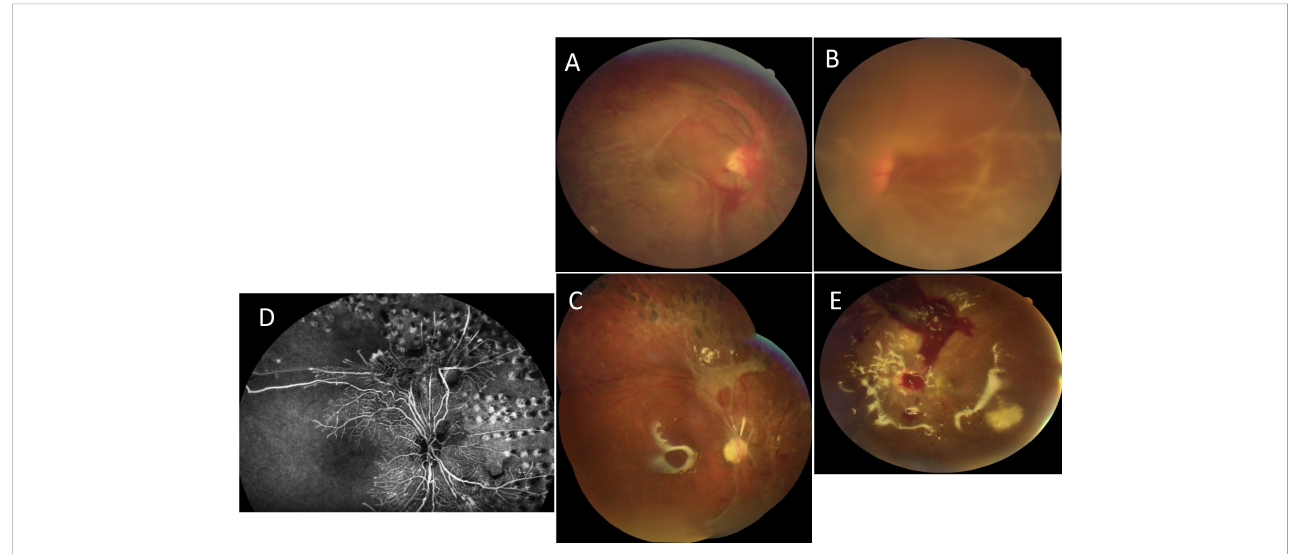
FIGURE 4 Case number 8. Multimodal imaging of a 20-year-old female from the Middle East with a diagnosis of mixed connective tissue disease following positive anti-dSDNA, anti-Smith, anti-RNP and anti-nucleosome antibodies and clinical signs that included oral ulcerations, polyarthralgia, malar rash squamous erythema of the ears and proteinuria diagnosed as extra-membranous lupus glomerulonephritis type V. She presented to the clinic with acute worsening of vision bilaterally. (A) Fundus photo of the right eye and (B) left eye show dense vitreous hemorrhage, vasculitis and tractional membranes. (C) Fundus photo of the right eye and (E) left eye following treatment with PPV, EL and SO. The left eye suffered from recurrent vitreous hemorrhage despite surgical interventions, which can be seen centrally and superiorly. (D) Wide fi eld FA of the right eye with superior and central lack of perfusion, compatible with extensive macular ischemia. She was treated systemically with steroids, MMF and